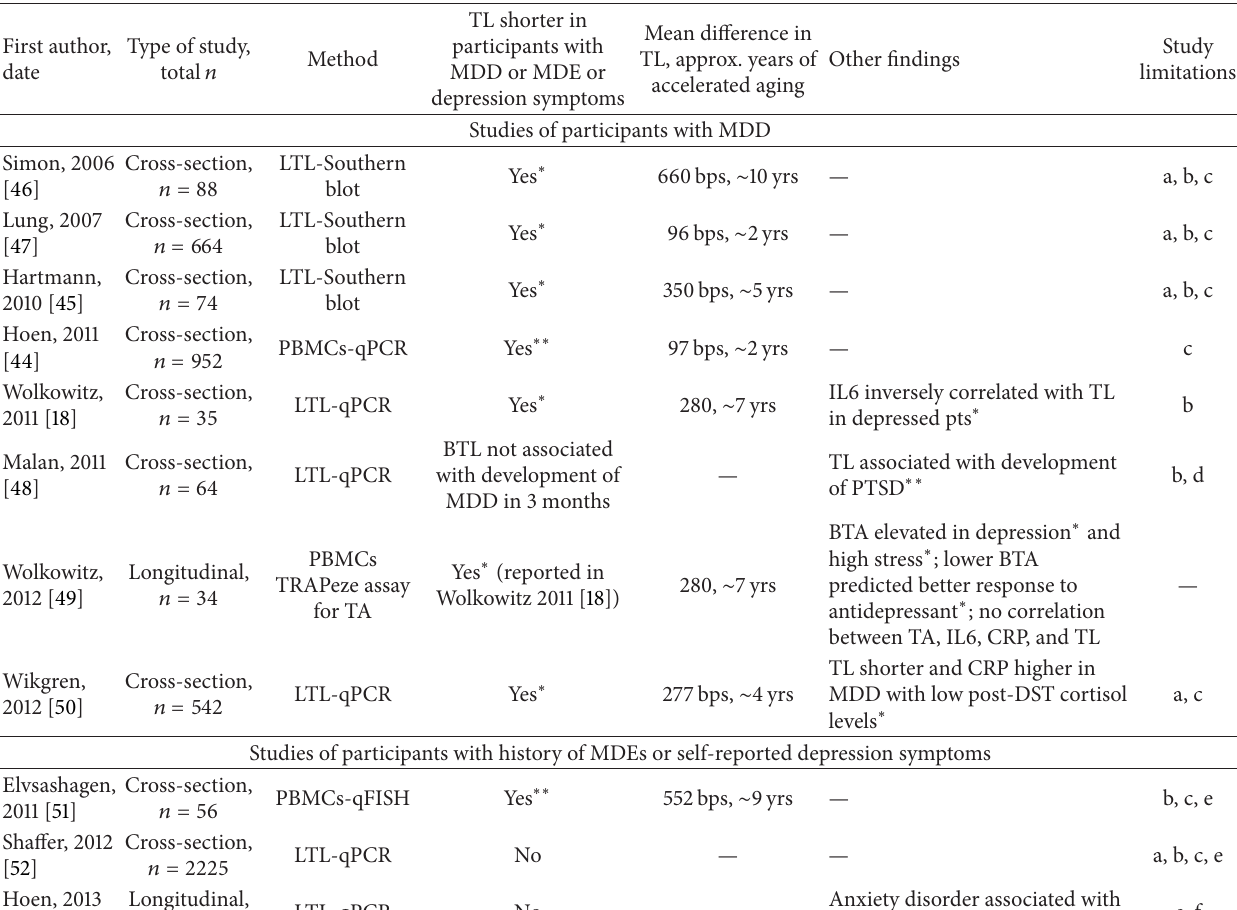
Table 1: Overview of studies: telomere length and